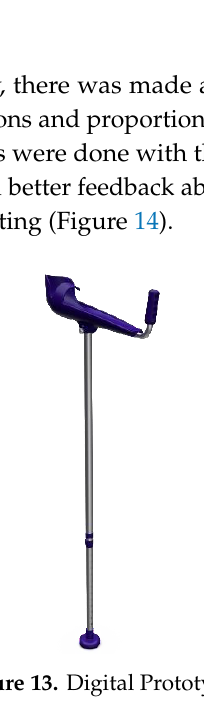
Figure 14. 1:5 Scale Prototype. For what concerns about the functional and virtual prototypes, they have not been done yet. The same was made for the Application: its aesthetic was checked with Adobe Illustrator, and its functionality with Adobe XD. 3.2.3. Testing The application has been tested by an experienced physiotherapist, who considered very useful some specific parts of the service, especially the graphs that show whether the load on the crutch increases or decreases over time; in fact, that graph allows us to understand if the patient is healing or not. Currently, another physiotherapeutic center is also interested in the idea, and would like to contribute to the improvement of the product and the service. In the future tests, it will certainly be tested with the users, to validate the simplicity of the service and the functionality of the prototype. 4. Results and Future Development From the What-How Matrix (Table 4) it resulted that the three features to innovate were: tip, adjustable height and material. Furthermore, there have been added innovative features, thanks to the use of sensors for usage monitoring and fall alarm. In the final stages of the design there was made the Top-Flop Analysis another time, to understand if the product had succeeded in innovation, and then were compared the features implemented with those of the Innovation Column. As in Table 3, the Flops were marked with the red background, the Tops with the green backgroud. The Δ turned out to be 4, (higher than 2, emerged in the first Top-Flop Analysis); this means that four characteristics of the crutches analyzed in the benchmarking had been improved (Table 10).